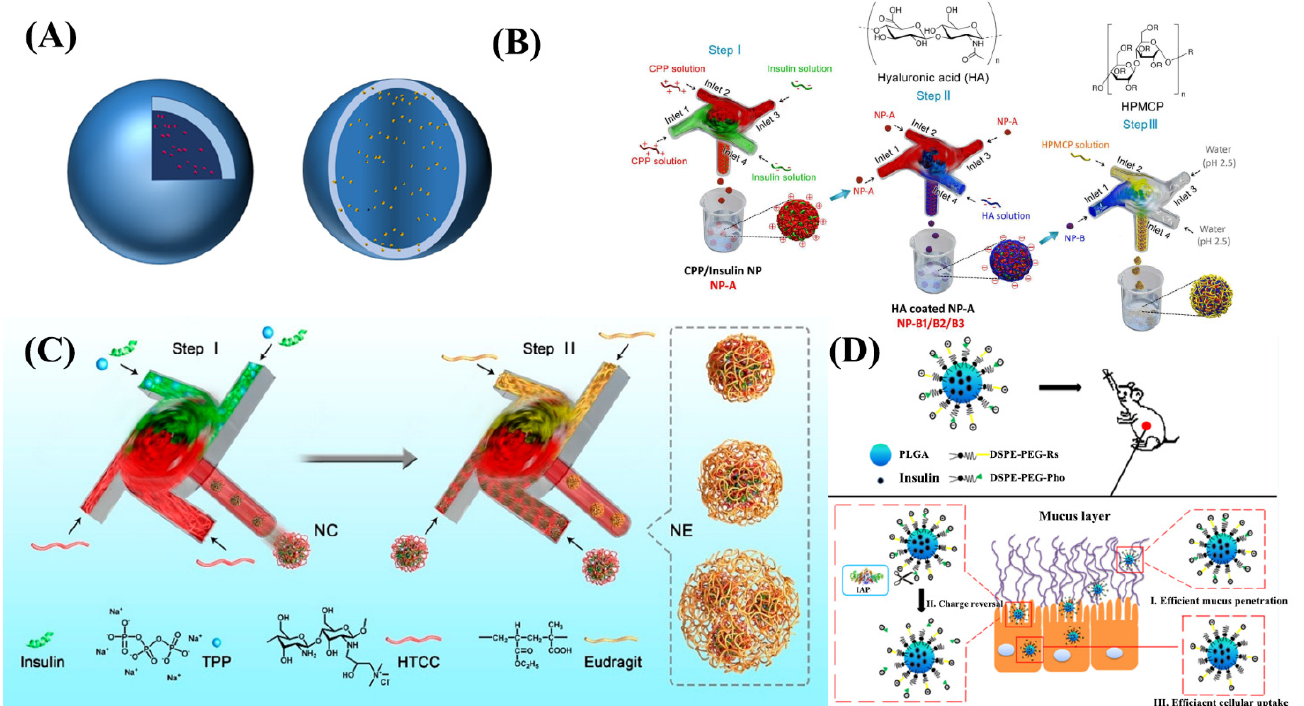
Figure 6. ( A ) Structures of organic nanospheres/nanocapsules. ( B ) Schematic representation of sequential FNC platform for preparation of the CPP/insulin nanoparticles. ( C ) The structure and the preparation process of NC-HTCC. ( D ) The structure of virus-like P-R8-Pho NPs and diagram of P-R8-Pho NPs to sequentially overcome mucus layer and intestinal epithelial cell layer.